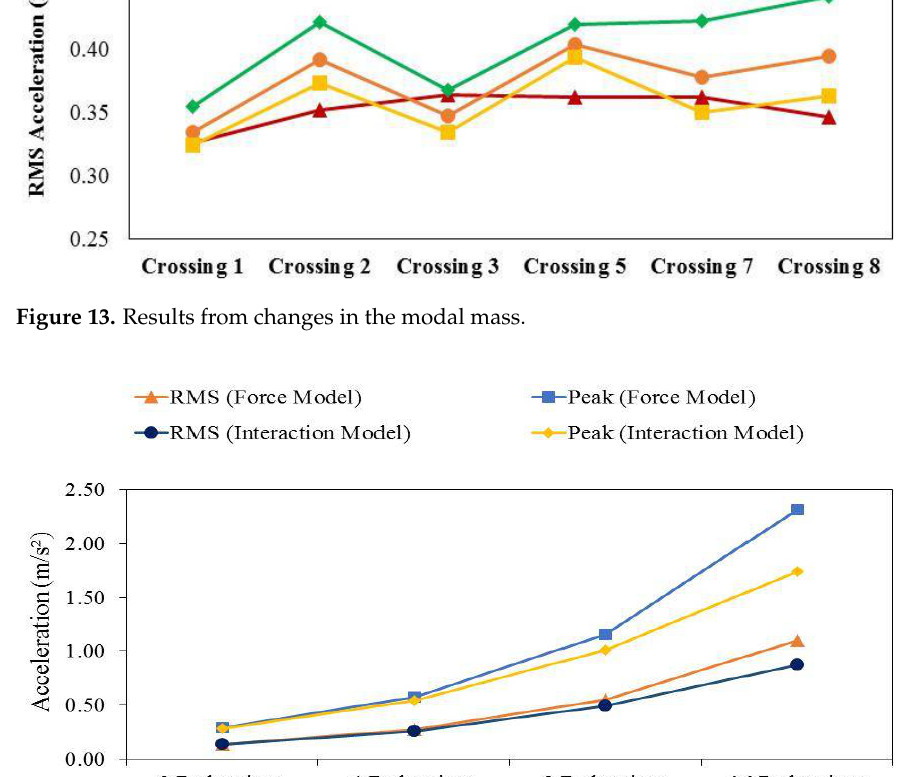
Figure 14. Peak and RMS accelerations for the two pedestrian models.